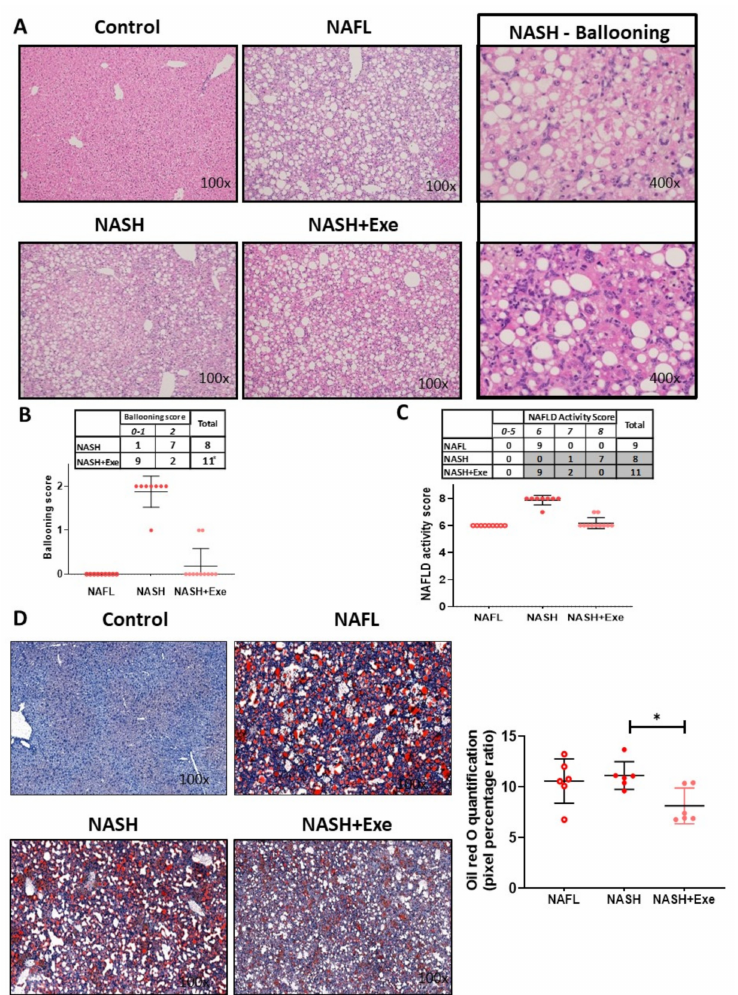
Figure 2. Effect of exercise on liver histology in mice fed a choline-deficient high-fat diet (CD-HFD). ( A ) Microscopy of hematoxylin and eosin (H&E)-stained liver sections showing diffuse macrovesicular steatosis in the NAFL, NASH and NASH + exercise (EXE) groups and the presence of ballooned hepatocytes only in the NASH sedentary group ). ( B ) Frequency table and dot plot comparing the ballooning score in the NASH sedentary and NASH + EXE groups. Ballooning was significantly lower in the NASH + EXE group (Fisher’s exact test, p = 0.005). ( C ) Frequency table and dot plot showing the NAFLD activity score in the NAFL, NASH sedentary, and NASH + EXE groups. The score was significantly lower in NASH + EXE than in the NASH sedentary group (Fisher’s exact test with Freeman–Halton extension, NASH vs. NASH + EXE, p < 0.0001). ( D ) Oil Red O staining comparing neutral lipid content of control, NAFL, NASH sedentary, and NASH + EXE livers. The quantification of lipid staining (right panel) was done with MetaMorph ® analysis software. Lipid content was lower in the NASH + EXE livers (unpaired t -test; * p < 0.05